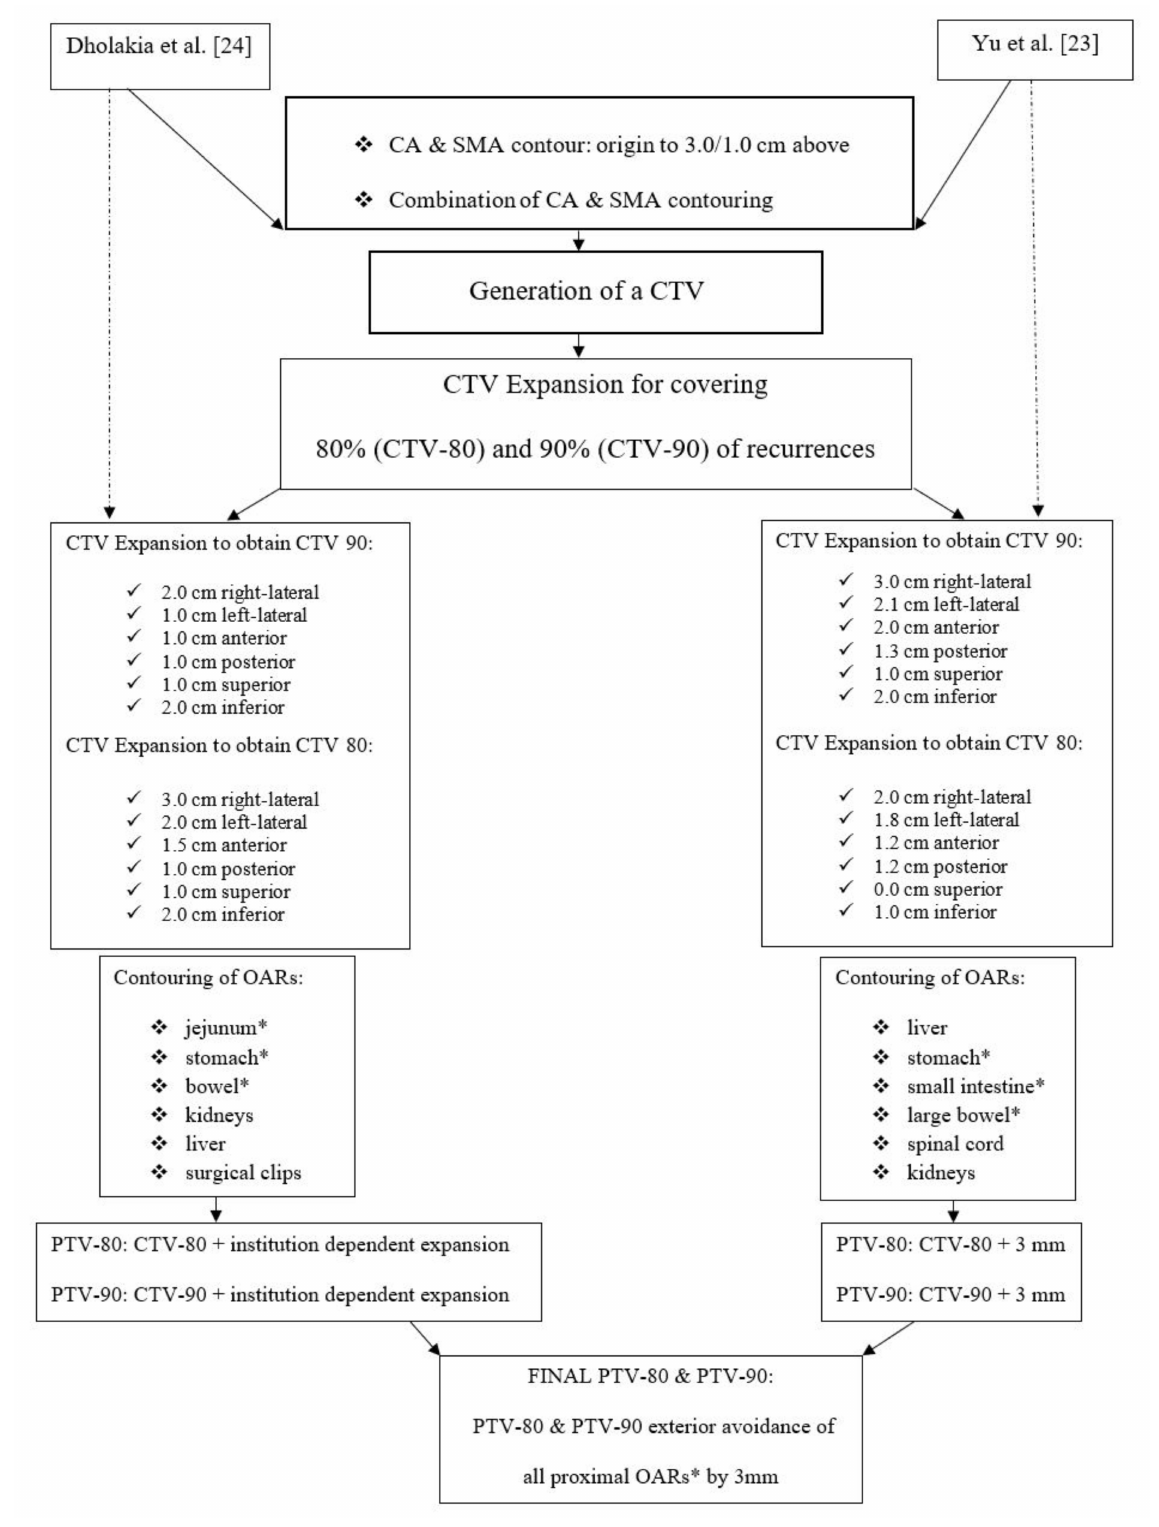
Figure 1. Stepwise planning process based on Dholakia et al. [24] and Yu et al.